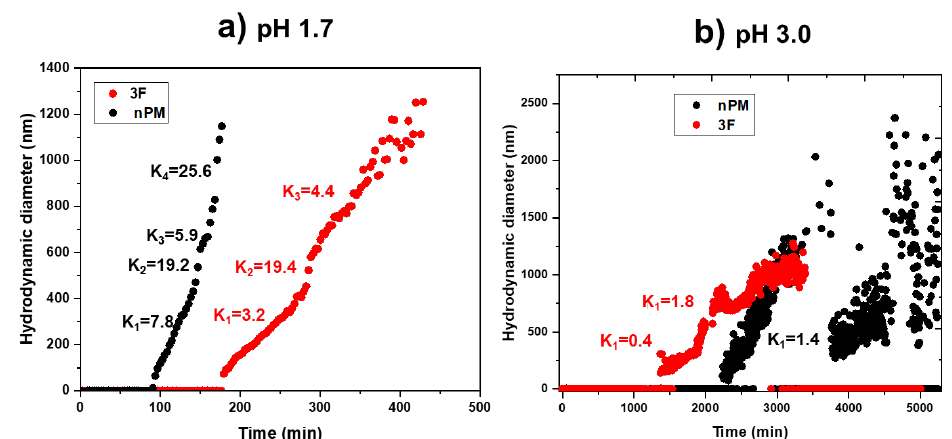
Figure 9. Comparison of the hydrodynamic sizes of the colloidal particles evolved during the hydrolysis and condensation of nPM (0.1 M) and 3F (0.1 M) at pH 1.7 ( a ) and pH 3.0 ( b ). Slopes are indicated for a relative comparison of particle formation rates.